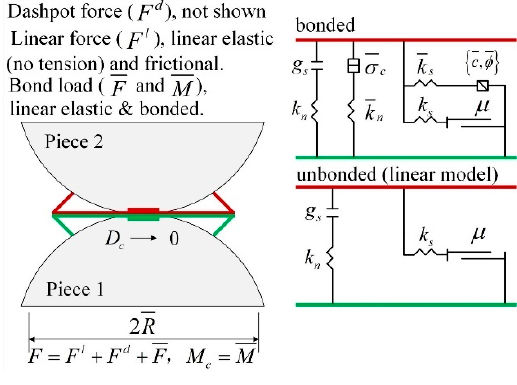
Figure 19. Parallel-bond model.